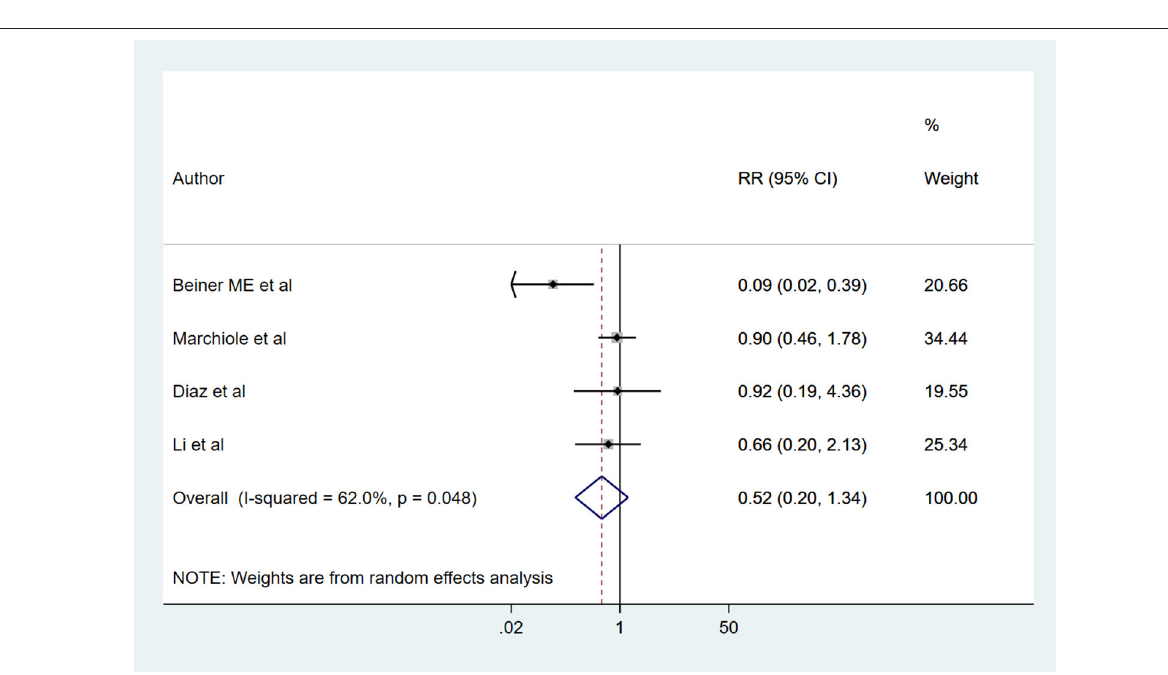
Frontiers in Surgery |